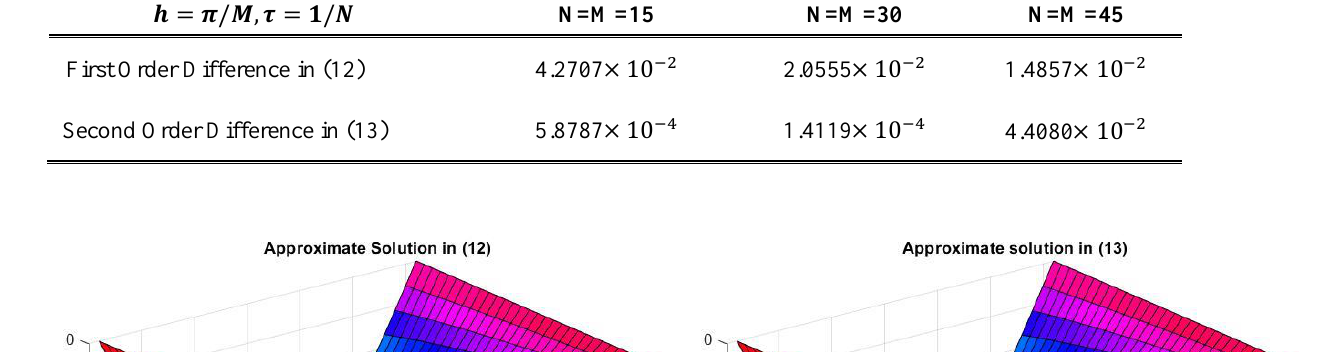
Table 2. Absolute Error for the Difference schemes in (12) and (13) in different values of N and M 𝒉 = 𝝅/𝑴, 𝝉 = 𝟏/𝑵